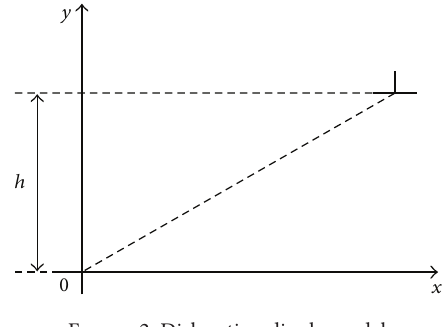
Figure 2: Dislocation dipole